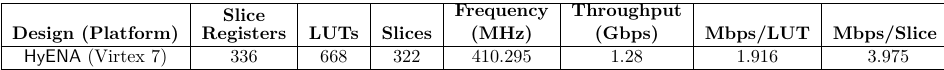
Figure 9: Hardware Architecture Diagram Table 3: FPGA implementation results of